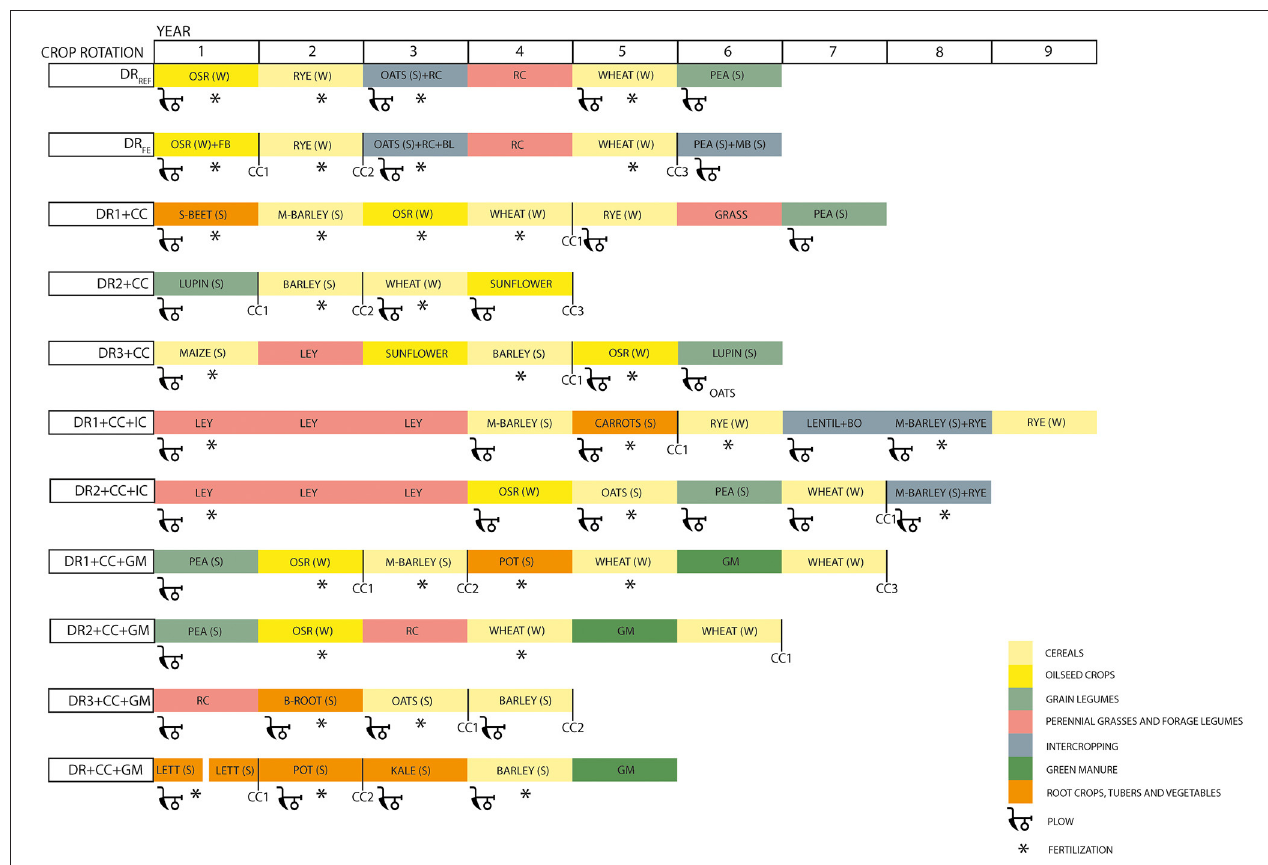
FIGURE 1 | Illustration of the 11 cropping systems included in the sustainability analysis. (W) refers to winter crops and (S) refers to spring crops. OSR, oilseed rape; RC, red clover; FB, faba bean; BL, blue lupin; M-barley, malting barley; S-Beet, sugarbeet; BO, black oats; POT, potatoes; GM, green manure; B-root, beetroots; LETT, lettuce. CC corresponds to cover